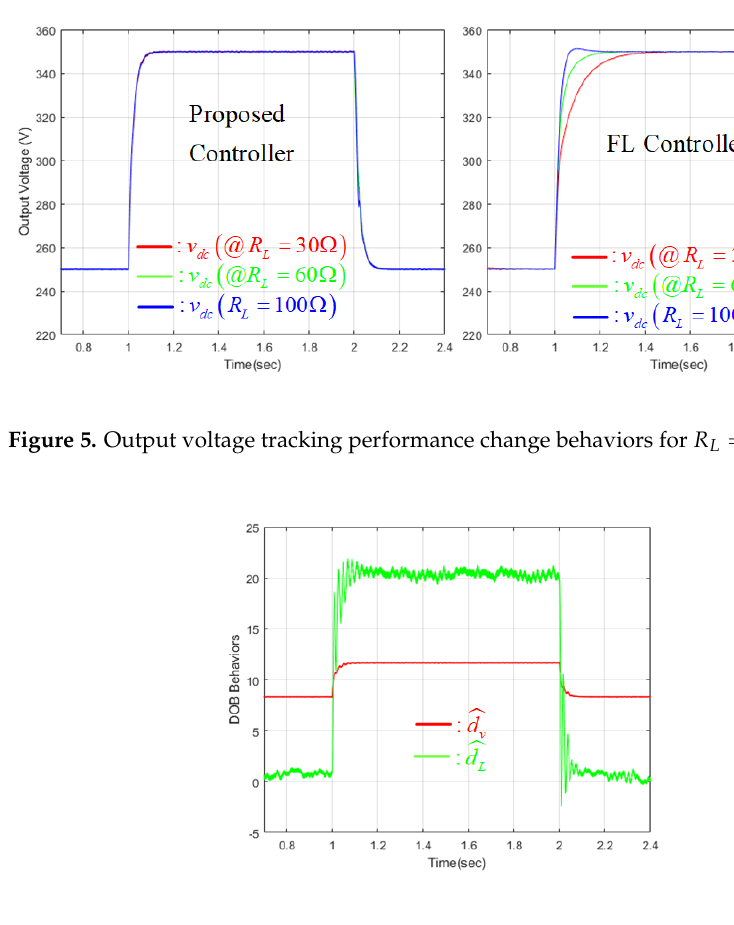
Figure 6. Estimated disturbance behaviors.